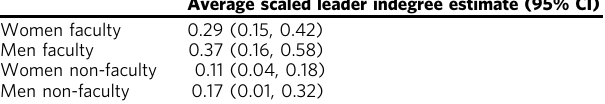
Table 2 Average scaled indegree of faculty and non-faculty in the who is a leader social network, accompanied with a 95% con fi dence